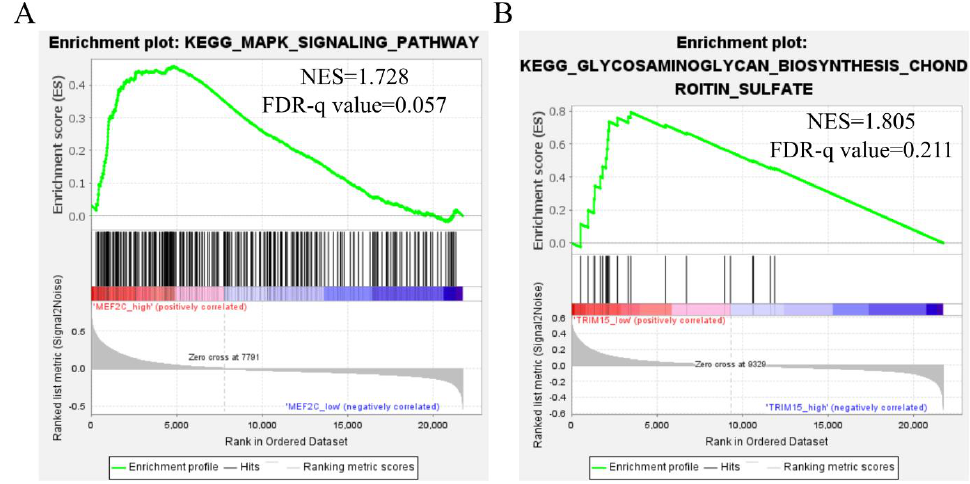
Figure 7. Gene set enrichment analysis was used to showed MEF2C high expression group ( A ) and TRIM15 low expression group ( B ) enriched signaling pathways.